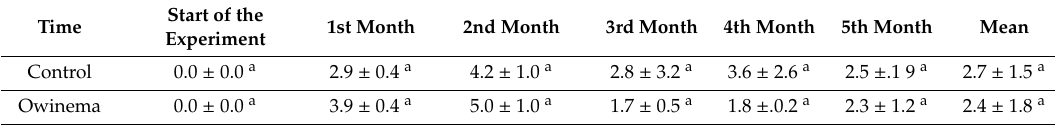
Table 4. Mean cocoon production (cocoons · mature ind − 1 ± SD) of mature Eisenia fetida individuals in experimental ecological boxes depending on the presence of Owinema bio-preparation (50 mln larvae m − 2 ) during a 5 month experiment.